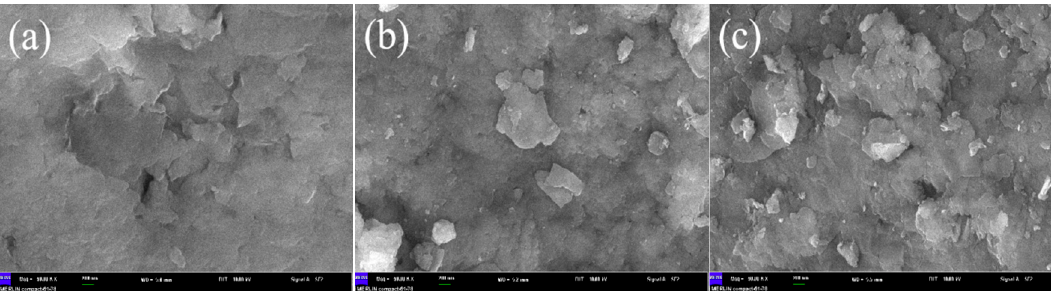
Figure 4. Scanning electron microscopy (SEM) images of ZnAl–LDH ( a ), FePcS–LDH ( b ), and FePcS–PMA–LDH ( c ).